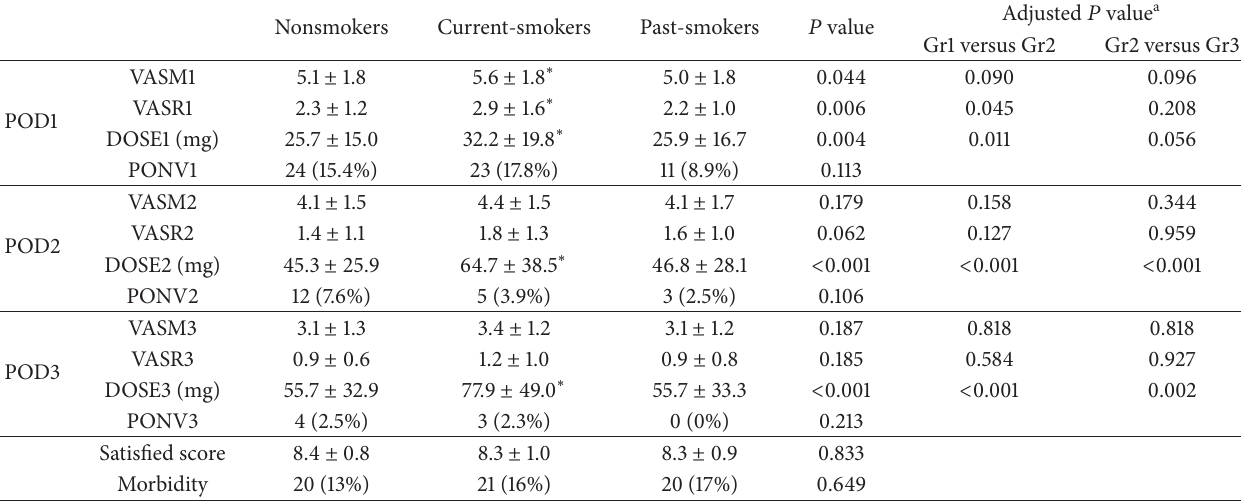
Table 4: Comparisons for postoperative outcomes on male